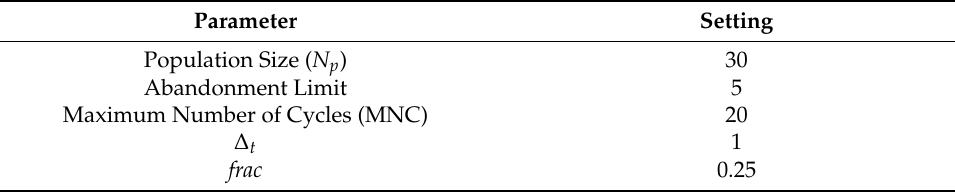
Table 5. Parameter settings for the ABC algorithms.